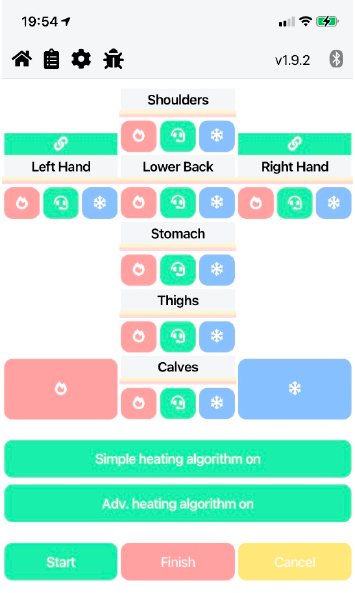
Figure 4. Smartphone control application.